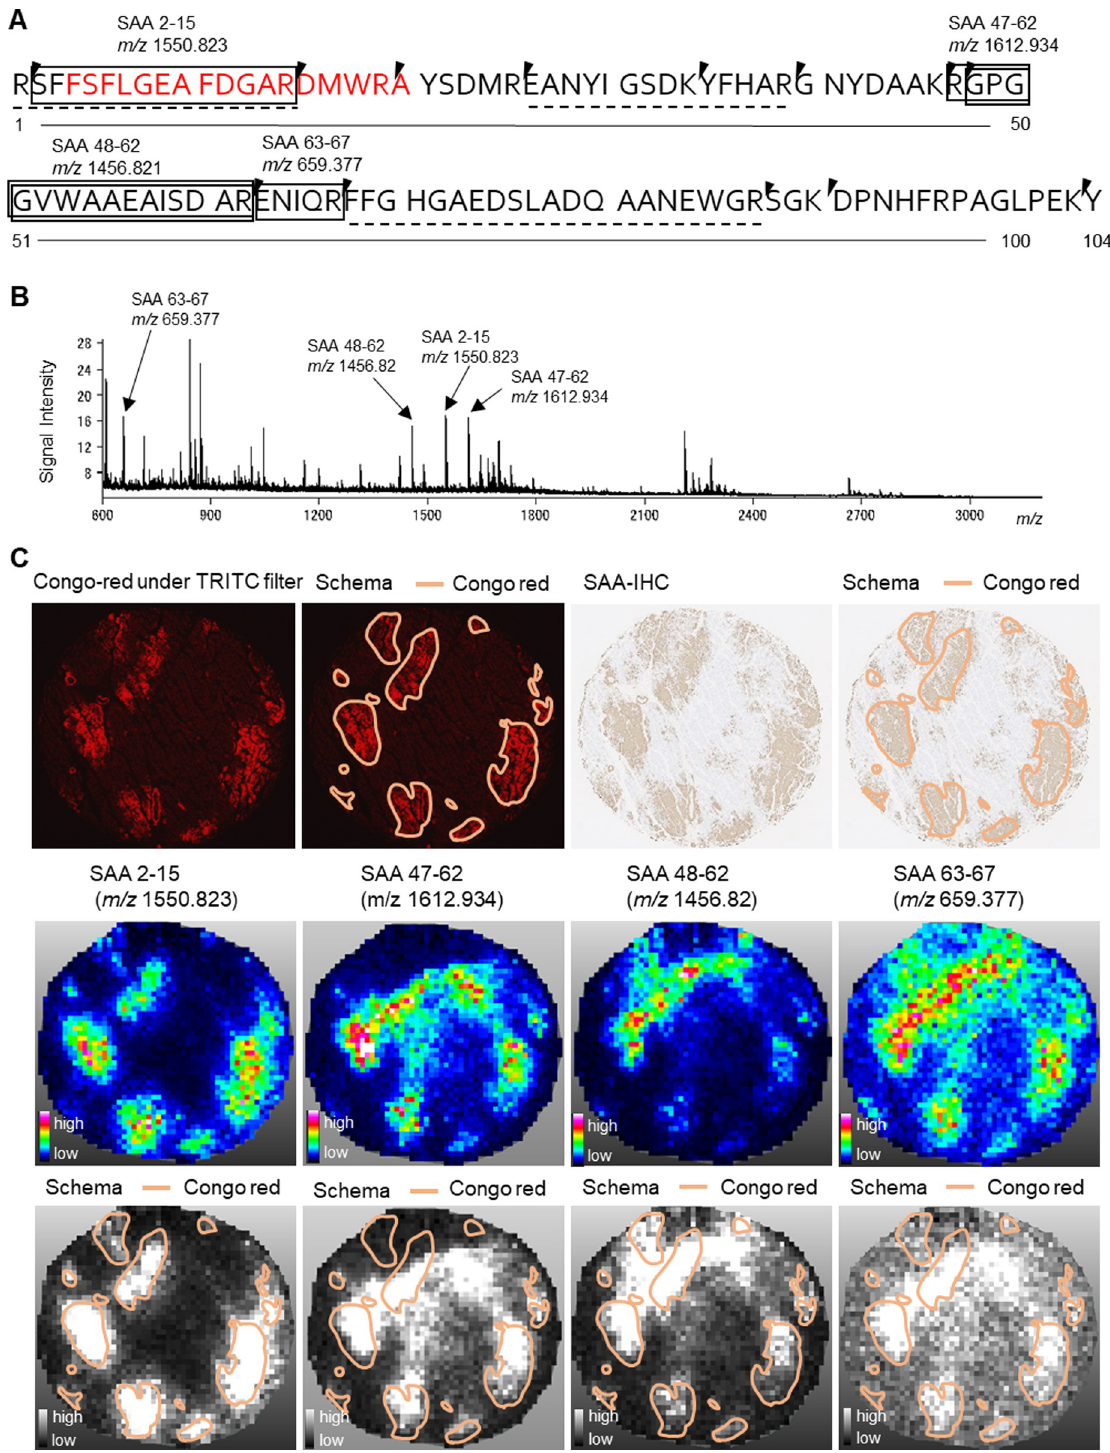
Fig 1. N-terminal peptides of serum amyloid A in cardiac tissues of AA amyloidosis. A. Sequence of human Serum Amyloid A1 (SAA1): SAA 4–20; shown in red, is the recognition site of antibody (mc1) to SAA. Four tryptic peptides, SAA 2–15, SAA 47–62, SAA 48–62, and SAA 63–67, detected by matrix-assisted laser desorption/ionization -time of flight spectrometry (MALDI-TOF MS) in this study, are enclosed in the box. Arrowheads indicate digestion sites by trypsin. Three tryptic peptides, SAA 1–15, SAA26-39 and SAA 68–87 with dotted lines were detected by liquid chromatography mass spectrometry (MS)/MS in the myocardium containing both amyloid deposits